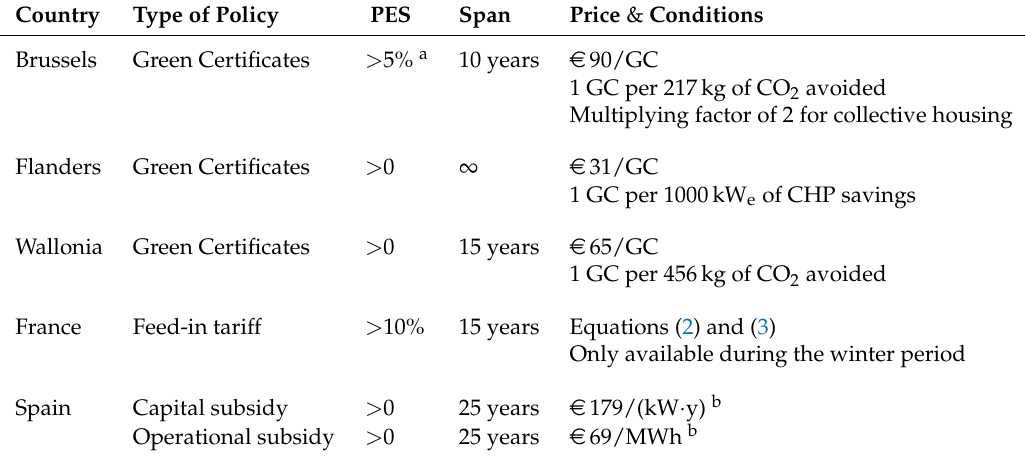
Table 1. Summary of the cogeneration policies applicable to 100 kW e units in the studied three countries (five